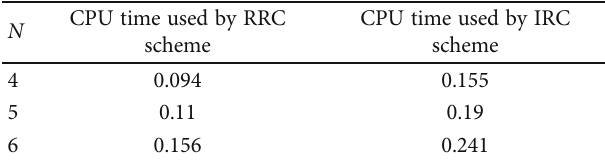
Table 1: Comparing the CPU time used by seconds for RRC and IRC